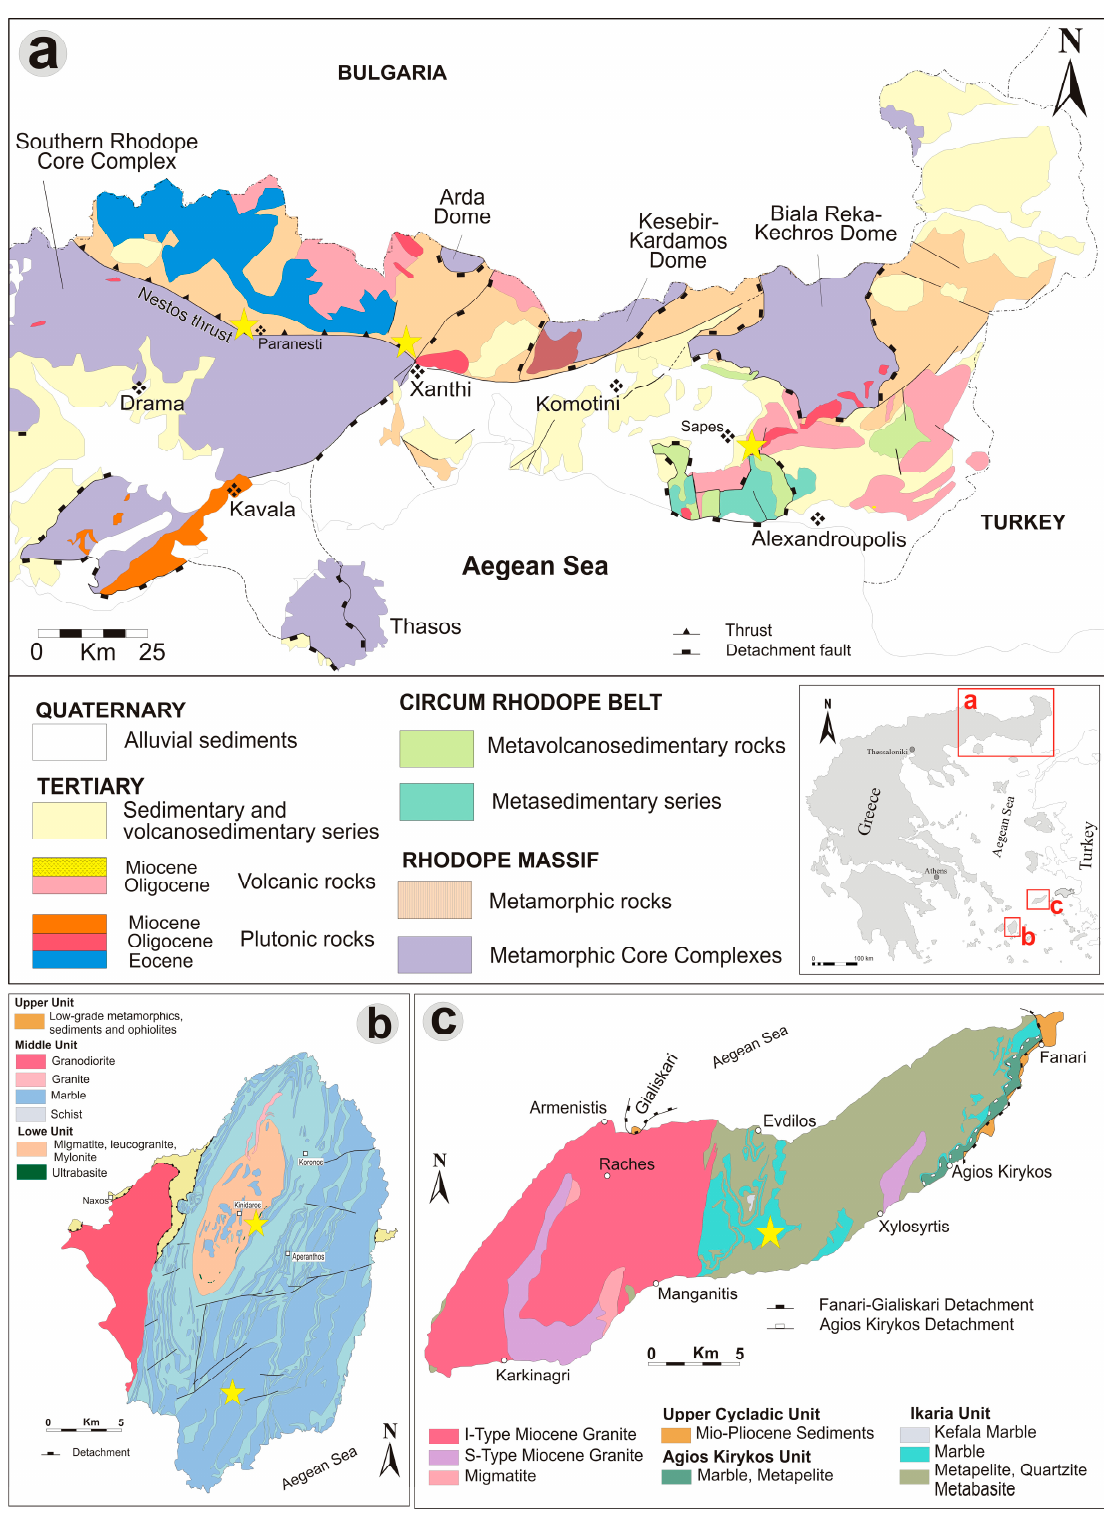
Figure 1. ( a ) Simplified geological map of eastern Rhodope massif, Greece showing the main tectonic zones and the distribution of Cenozoic igneous rocks (after Melfos and Voudouris [52] and references therein), showing location of corundums at Xanthi, Paranesti and Kassiteres/Sapes areas (stars); ( b ) Geological map of Naxos island showing locations of sapphires in plumasites at Kinidaros and meta-bauxites at Kavalaris Hill (stars) (after Duchêne et al. [53]; modified after Ottens and Voudouris [54]); ( c ) Geological map of Ikaria showing the location of blue sapphire in Atsida area (after Beaudoin et al. [55]; modified after Ottens and Voudouris [54]). Yellow stars mark the studied corundum occurrences.